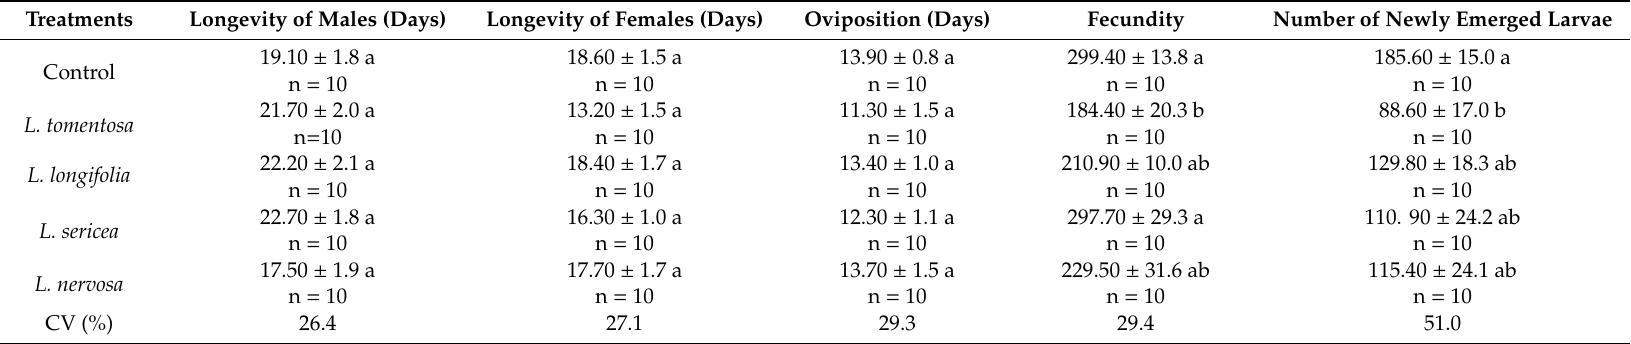
Table 2. Longevity of males and females (days), oviposition (days), fecundity and number of newly emerged larvae of Plutella xylostella treated with Ludwigia spp.